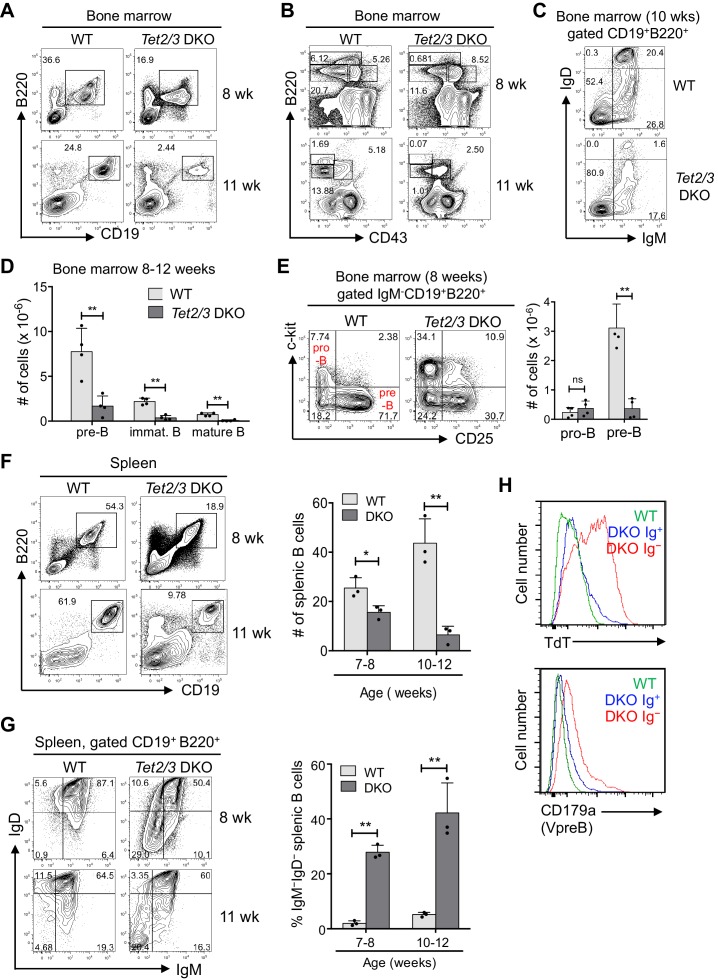
Loss of Tet2 and Tet3 in the B cell lineage results in B cell developmental blockade in vivo.(A) Reduced bone marrow B cells (B220+ CD19+) in Tet2-/-Tet3fl/fl Mb1Cre (Tet2/3 DKO) mice. Total bone marrow cells from wild type (WT) or Tet2/3 DKO mice at eight weeks (upper) and 11 weeks (lower) were analyzed for the percentage of total B cells (CD19+B220+) by flow cytometry and the representative plots are shown. Note that the loss of B cells is apparent at 8 weeks and more pronounced at 11 weeks. (B) Tet2/3 DKO mice display a striking reduction in pre-B cells. Bone marrow pre-B cells (IgM-CD43-B220+) were analyzed by flow cytometry and representative plots are shown. The absolute numbers of pre-B cells in 8–12 week-old mice are shown in Figure 1D. (C) Reduced frequency of immature (IgM+IgD-) and mature recirculating (IgM+IgD+) B cells in DKO bone marrow. CD19+B220+ bone marrow cells from 10 week-old Tet2/3 DKO and WT mice were analyzed for cell surface IgM and IgD expression. Data shown are representative and numbers of immature and mature B cells from four mice are shown in Figure 1D. (D) Quantification of cell numbers in multiple experiments similar to those shown in Figure 1B and C. (E) B cell development in Tet2/3 DKO mice is blocked at the transition from the pro-B cell to the pre-B cell stage. Bone marrow B cells (CD19+B220+) of Tet2/3 DKO or WT mice (eight weeks) were analyzed by flow cytometry for c-kit and CD25 expression. Left panel, Representative flow cytometry plots; right panel, numbers of bone marrow B cells at pro-B and pre-B cell stages were compared between WT and Tet2/3 DKO mice (n = 4). Pro-B cells, CD19+B220+IgM-CD25-c-kit+; pre-B cells, CD19+B220+IgM-CD25+ c-kit-. (F) Tet2/3 DKO mice have reduced splenic B cells. Total splenocytes from WT or Tet2/3 DKO mice were analyzed for B220 and CD19 expression by flow cytometry. Left panel, representative flow cytometry plots. Right panel, numbers of splenic B cells in WT and Tet2/3 DKO mice (n = 3 for each age group). (G) Accumulation of B cells lacking surface IgM or IgD expression in the periphery of Tet2/3 DKO mice. B cells (CD19+B220+) were analyzed for IgM and IgD expression. Left panel, representative flow cytometry plots. Right panel, compiled data of IgM-IgD- % from multiple experiments. Tet2/3 DKO mice show a considerable age-dependent increase in the proportion of IgM-IgD- B cells lacking surface B cell receptor. (H) IgM-IgD- B cells in the Tet2/3 DKO mice expressed high level of TdT (upper panel) and preBCR (CD179a, lower panel). Ages of mice are shown on the right for (A), (B), (F), and (G). Error bars indicate standard deviations. *, p<0.05, **, p<0.01 by Student’s t test. ns, not significant.